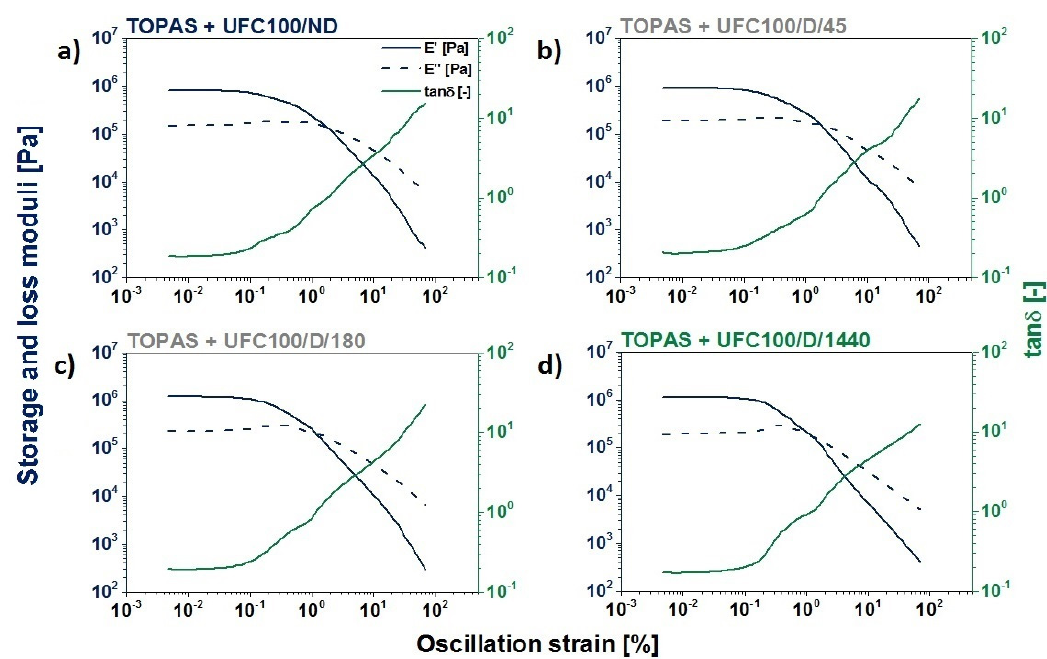
Figure 8. Storage modulus, loss modulus, and tan δ changes of the ethylene–norbornene copolymer (TOPAS) that was filled with cellulose fibers and dried for different times. ( a ) Not-dried, ( b ) dried for 45 min, ( c ) dried for 180 min, ( d ) and dried for 1440 min.